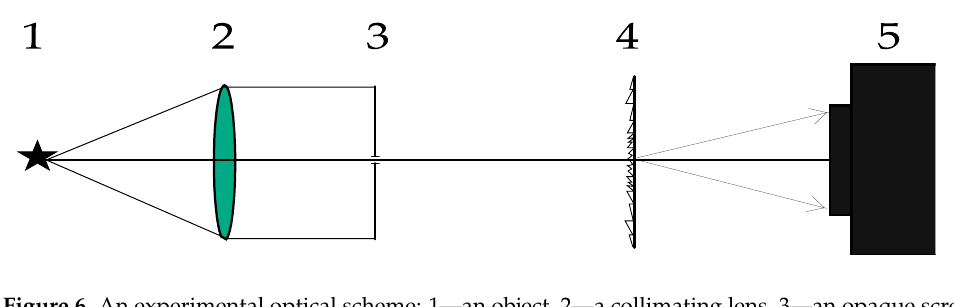
Figure 6. An experimental optical scheme: 1—an object, 2—a collimating lens, 3—an opaque screen with a pinhole, 4—an SDL, and 5—a camera.